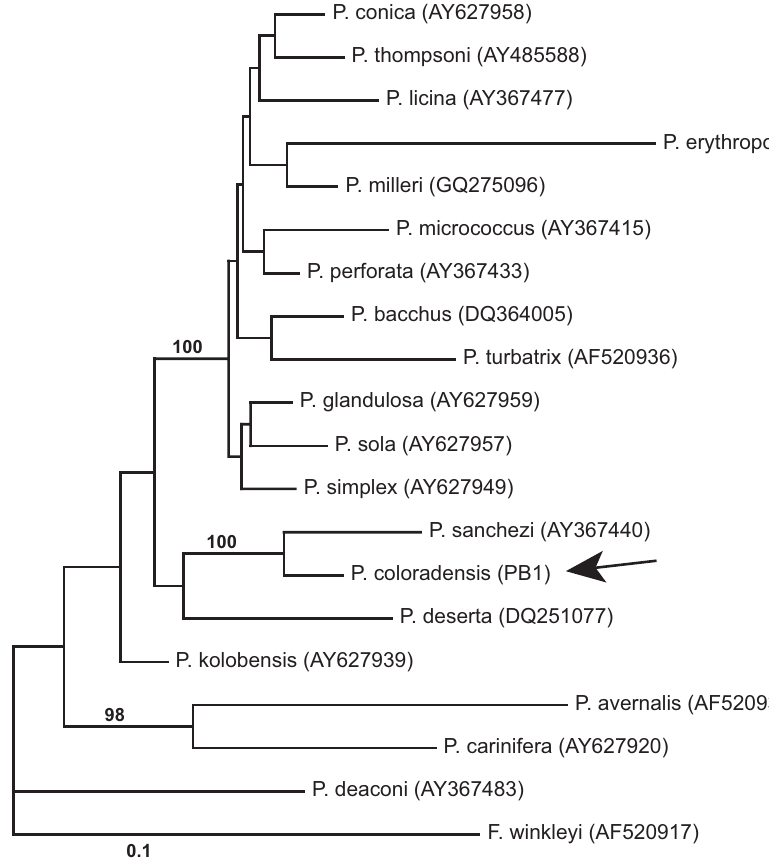
Figure 2. Bayesian tree based on COI data delineating the phylogenetic relationships of P. coloradensis (sequence identified by arrow). Posterior probabilities for nodes are indicated when >95%. GenBank ac- cession numbers for haplotypes are given in